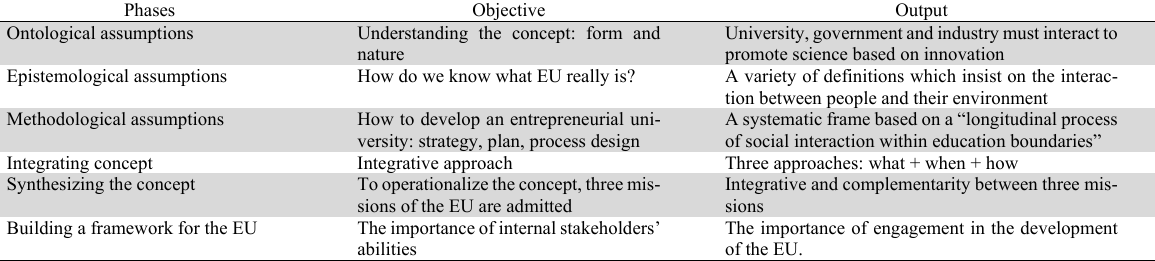
Entrepreneurial university process Phases Objective Output Ontological assumptions Understanding the concept: form and University, government and industry must interact to nature promote science based on innovation Epistemological